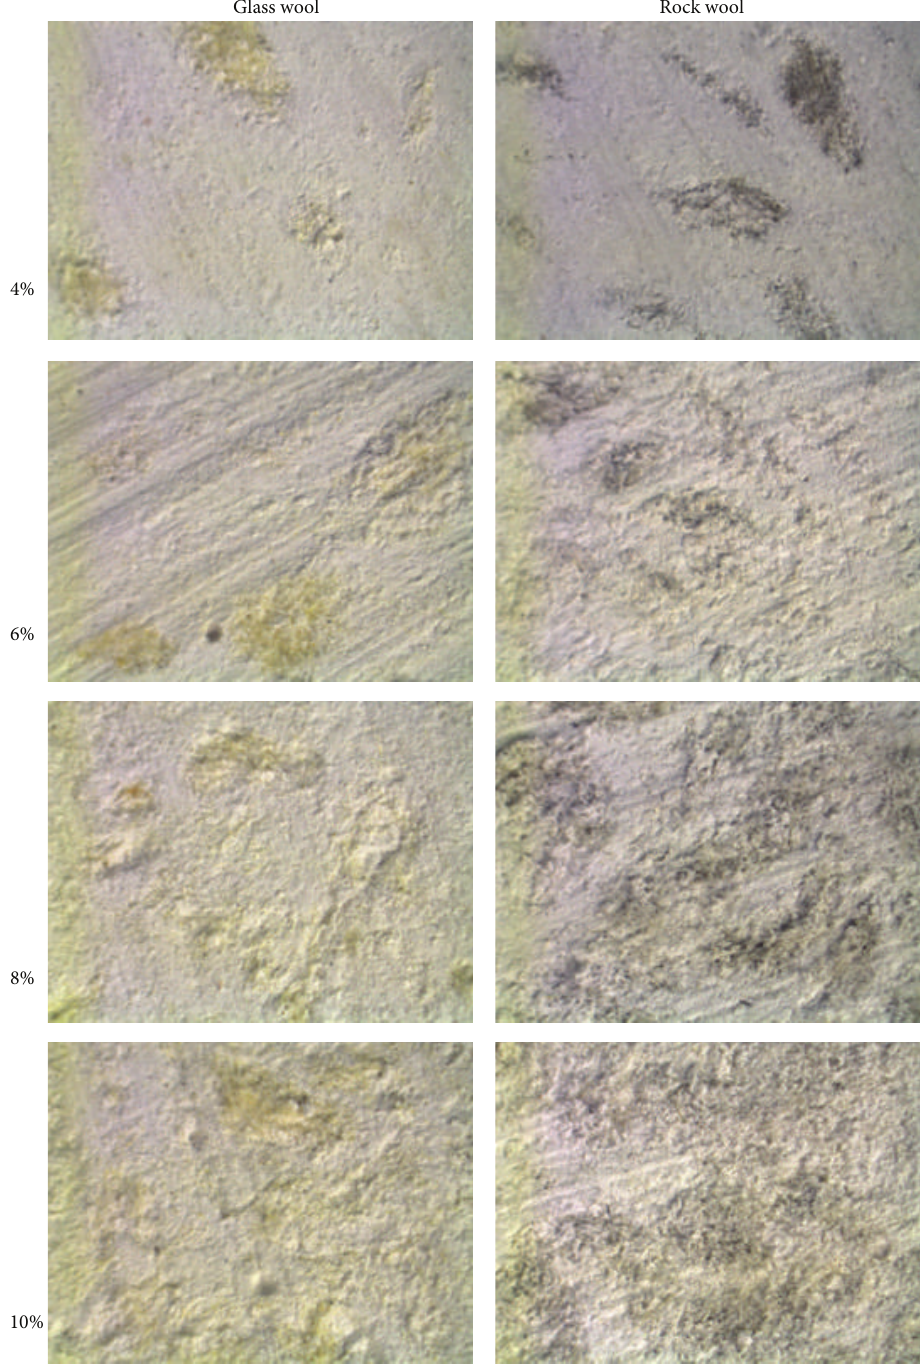
Figure 4: Plaster matrix with different glass and rock wool